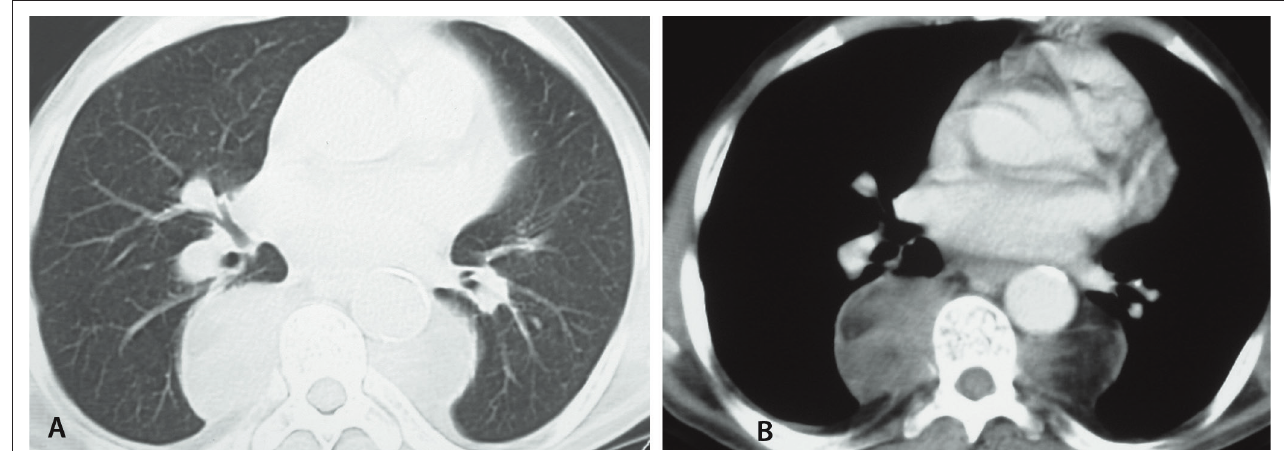
Fig. 1. Chest X-rays in frontal (A) and lateral (B) views revealed bilateral posterior lobulated retrocardiac masses. Pulmonary parenchyma and bone structures were normal.